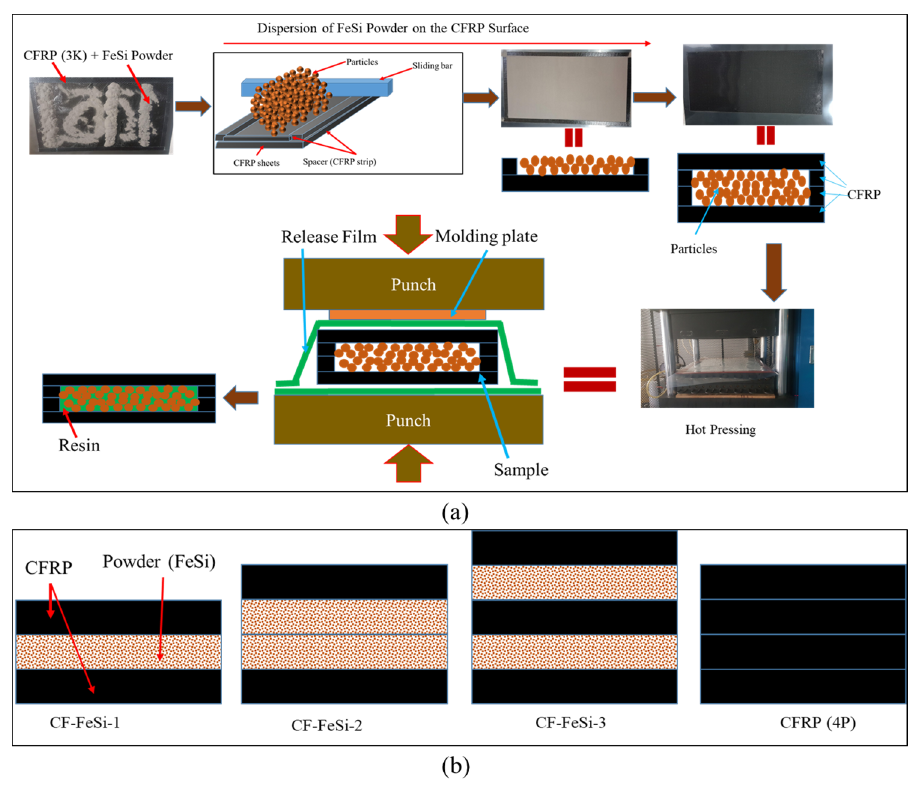
Figure 1. Carbon-fiber-reinforced polymer (CFRP)–FeSi composite fabrication: ( a ) manufacturing procedure; ( b ) CFRP-FeSi lamination designs.